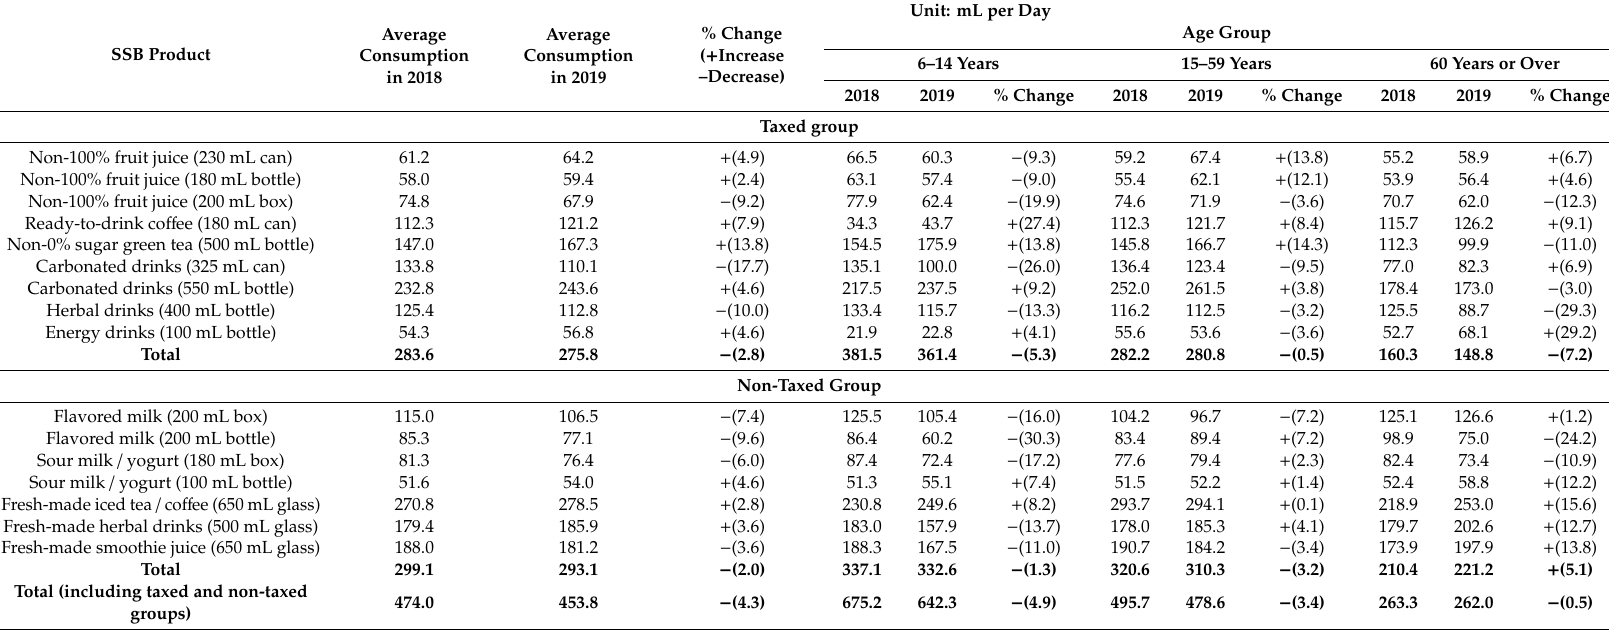
Table 3. Changes in consumption of sugar-sweetened beverages (mL / day) by taxed and non-taxed product and age group in 2018 and 2019.